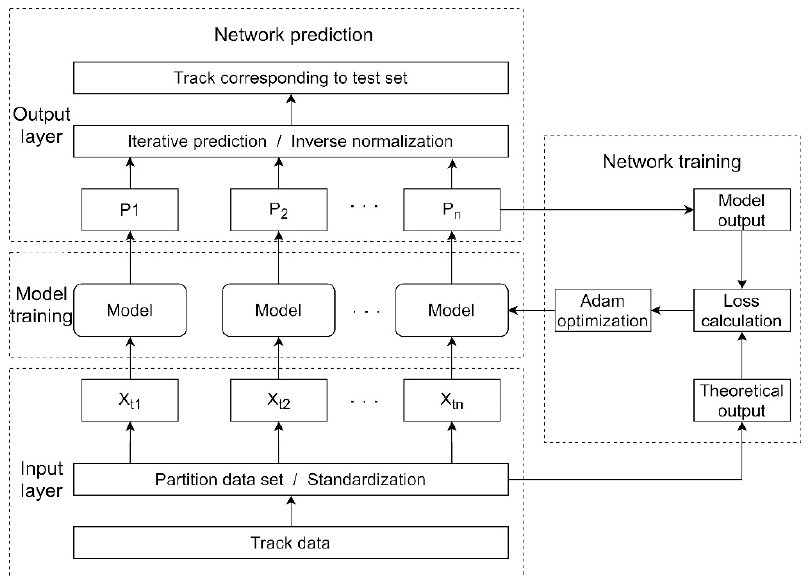
Figure 11. Training process of the proposed network. The original ship trajectory data are input to the prediction model after data segmentation and normalization. The model is trained through iterations to output the prediction results, and the results are back-normalized to obtain the pre- dicted trajectories.